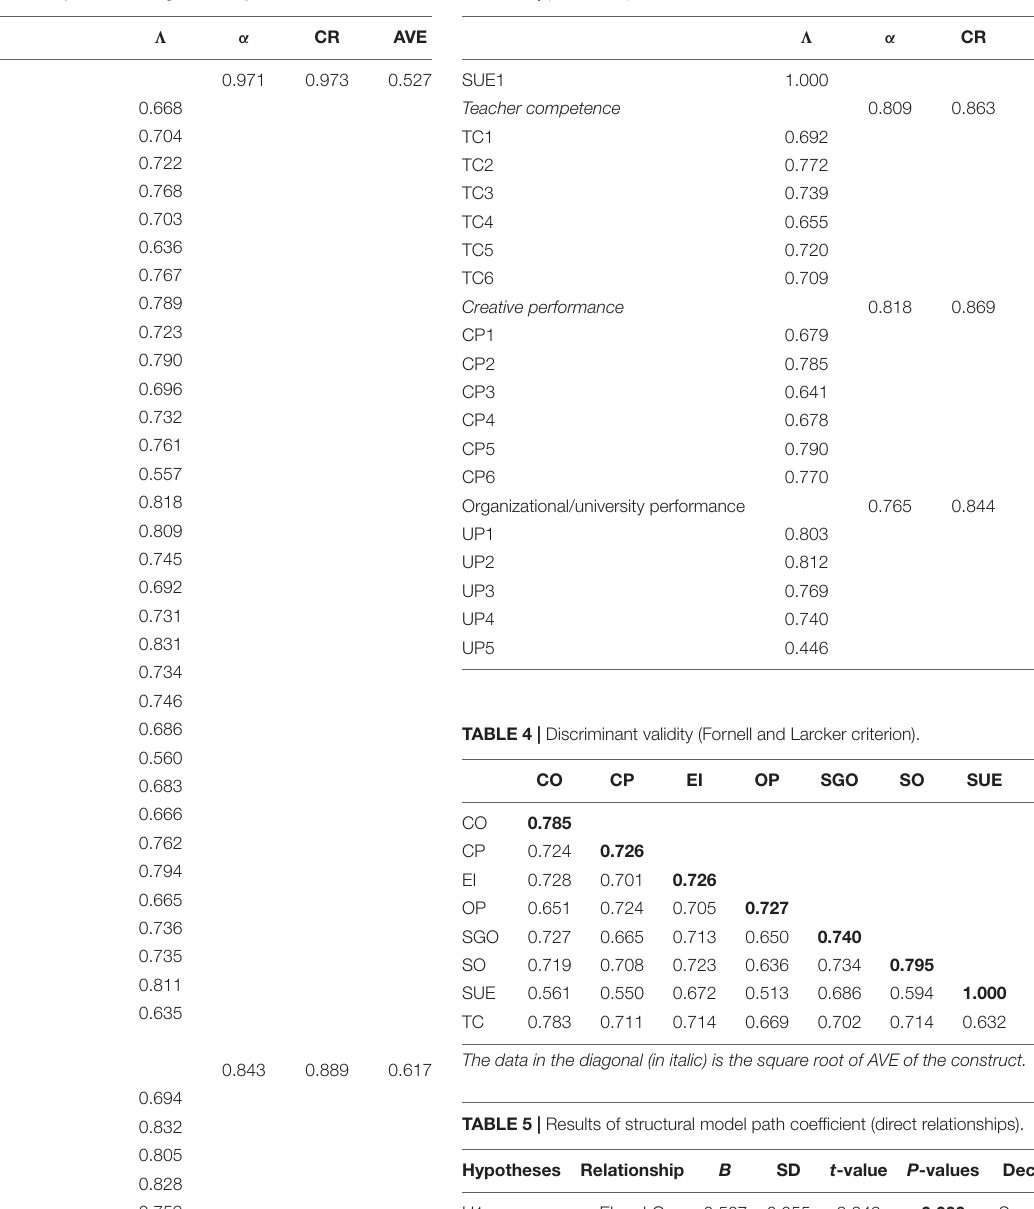
TABLE 3 | Item loadings, reliability, and convergent validity.